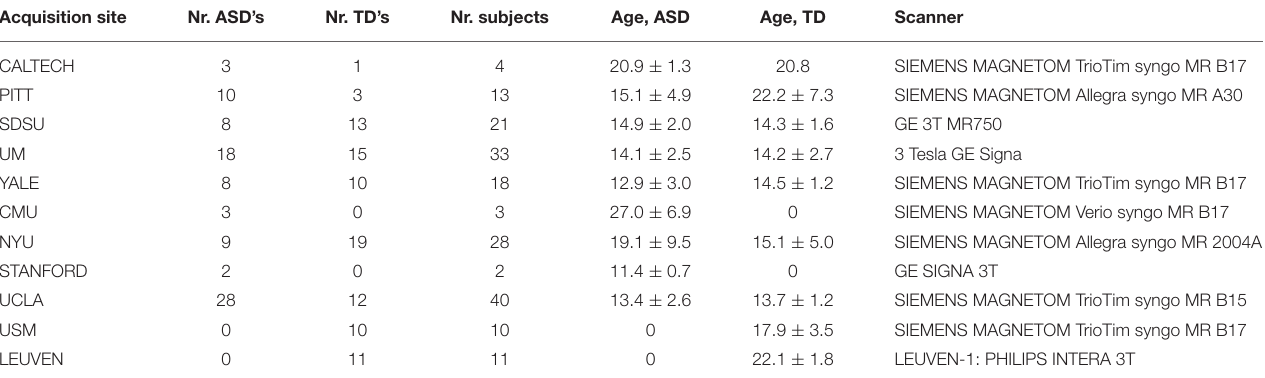
TABLE 1 | Summary table of the train and test datasets. Acquisition